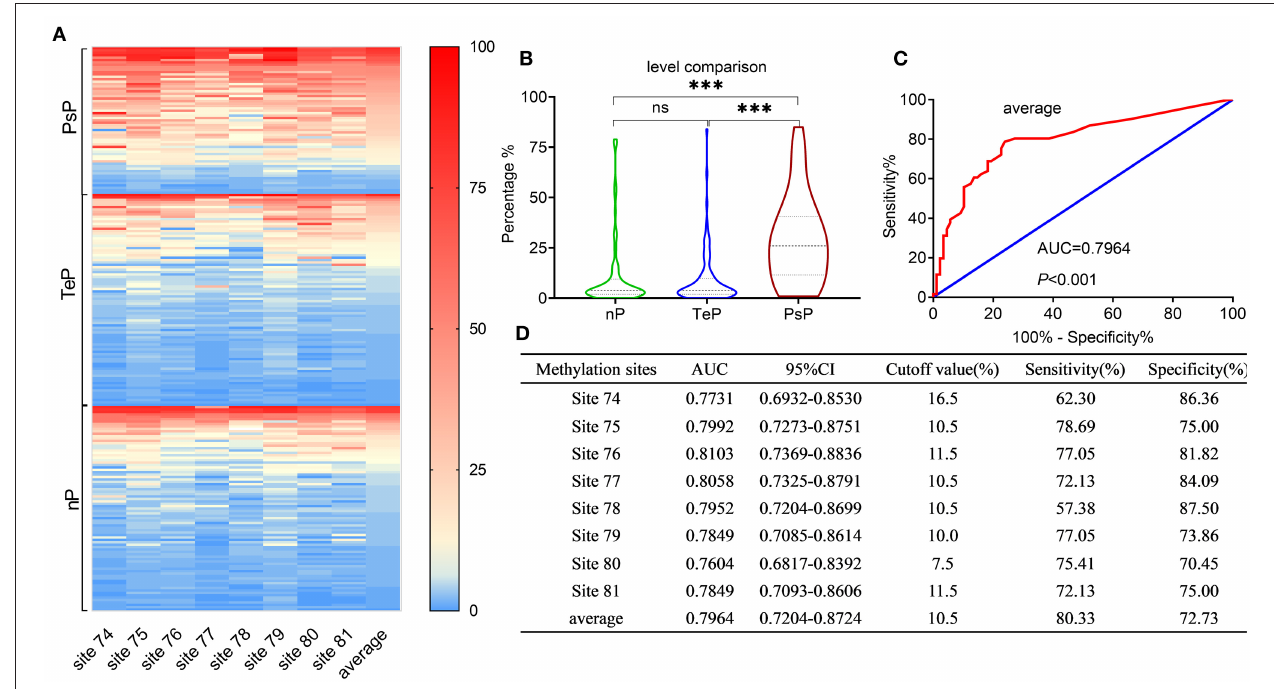
FIGURE 2 | Results of MGMTp pyrosequencing (PSQ) and diagnosis accuracy for PsP. MGMTp methylation level comparison among subgroups and ROC curve for diagnosing PsP. (A,B) The heatmap and violin figure presented that the MGMTp methylation levels in PsP were substantially higher than those of the other groups (median 26%, 4%, 4% for PsP, TeP, and nP, respectively, Kruskal–Wallis test, P < 0.0001), while no difference was observed between TeP and nP (Kruskal–Wallis test, P = 1). The average MGMTp methylation levels showed moderate and robust differentiation efficacy compared with a single CpG site (C,D) . *** P < 0.0001; ns, not